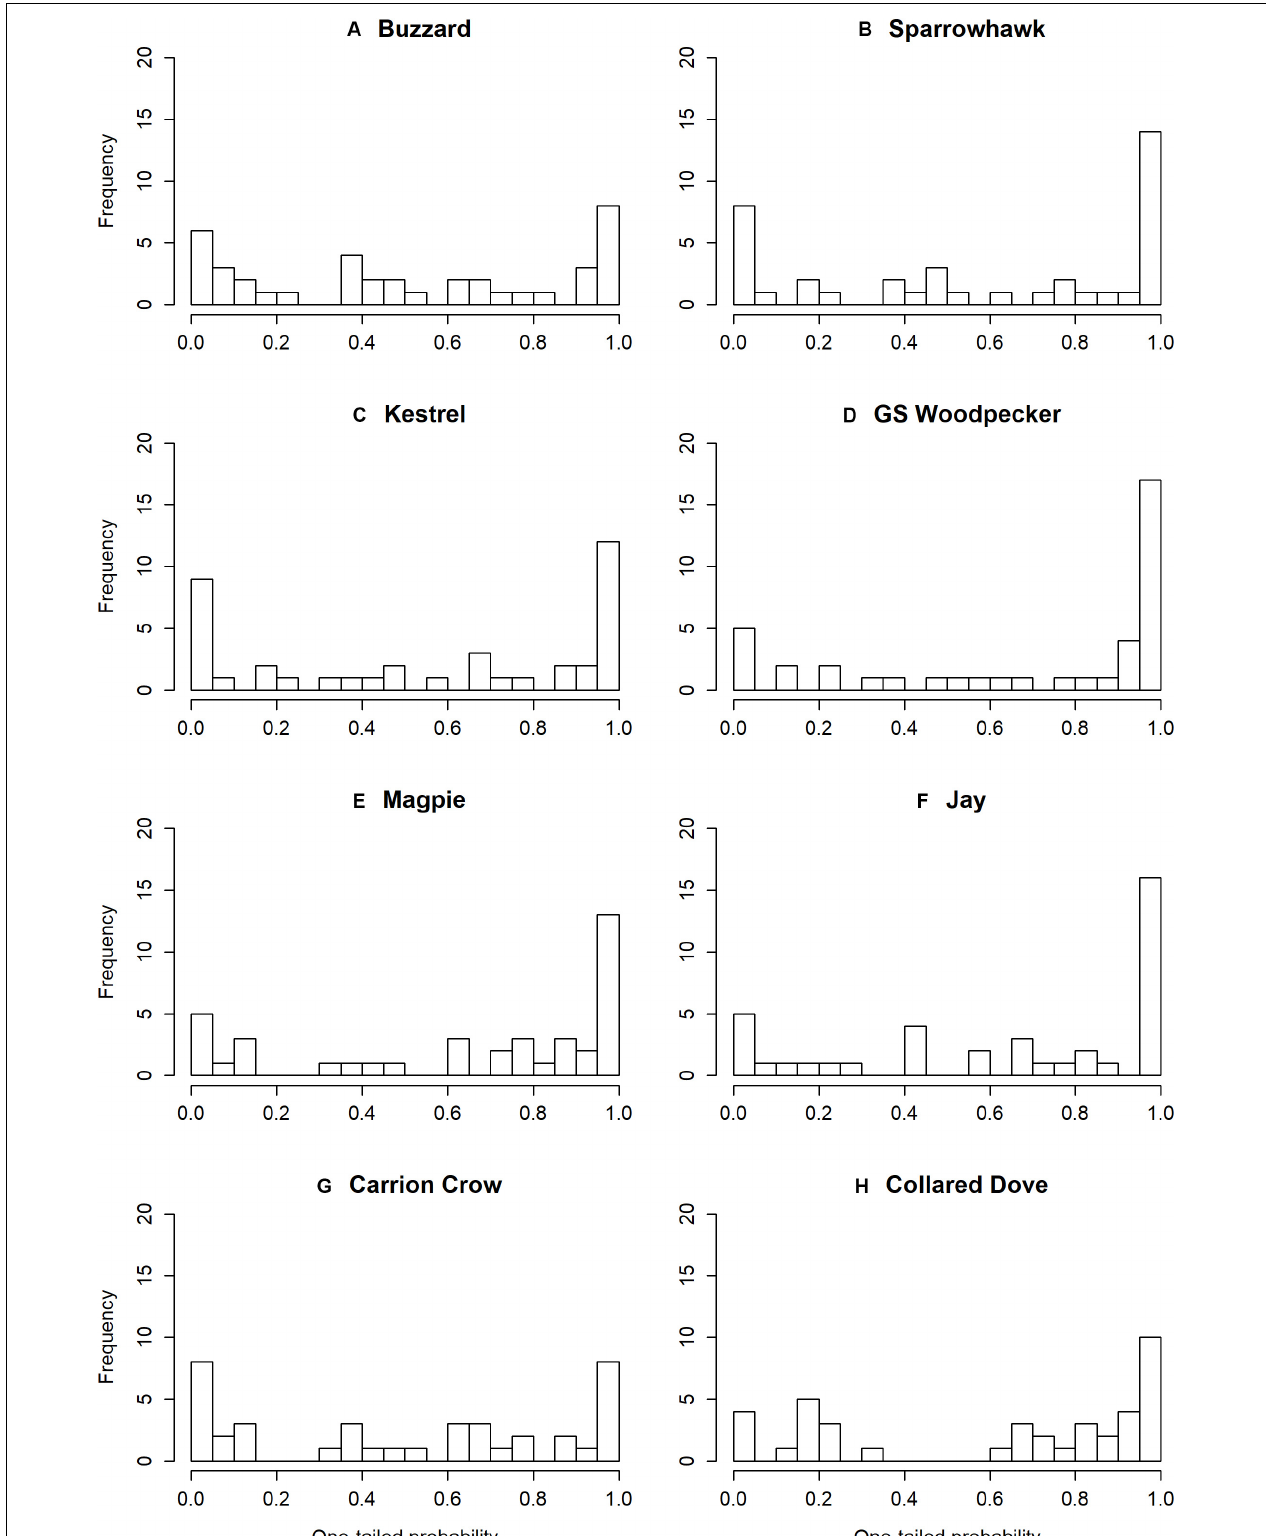
FIGURE 1 | Histograms of one-tailed probabilities for effects of predators on prey species. Parts (A–H) show prey species frequencies for each individual predator species.